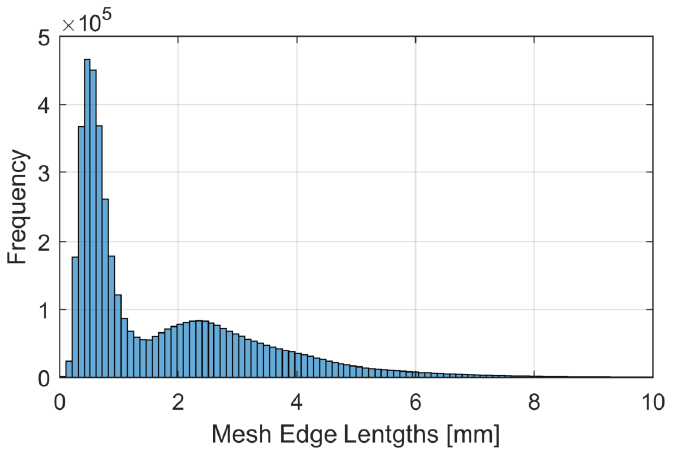
Figure 3. Histogram of the mesh edge lengths across all participants in the database.